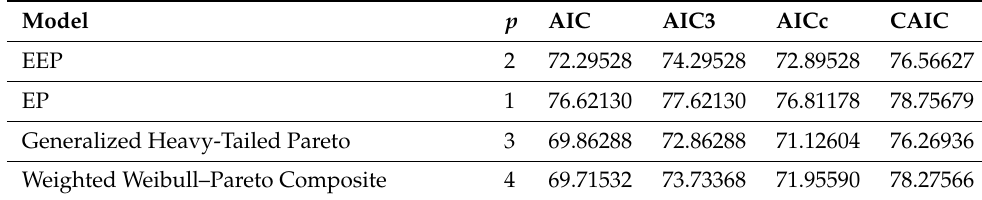
Table 4. Comparison of the four models in terms of the five GoF